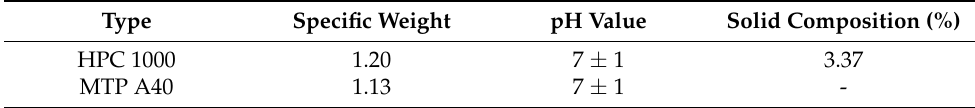
Table 4. Basic properties of the